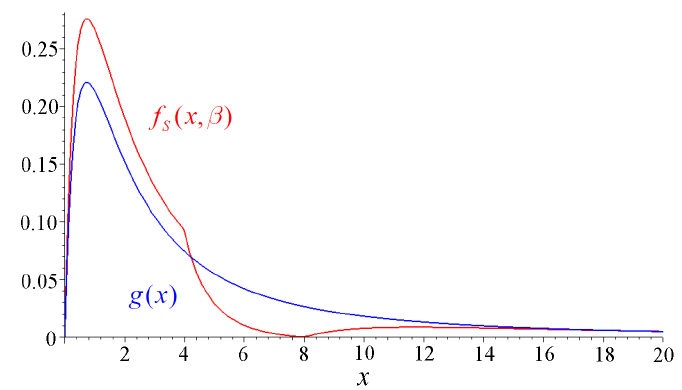
Figure 11: Plots of the densities f S ( x , β ) for β = 0.1 and g ( x ) in Example 3.